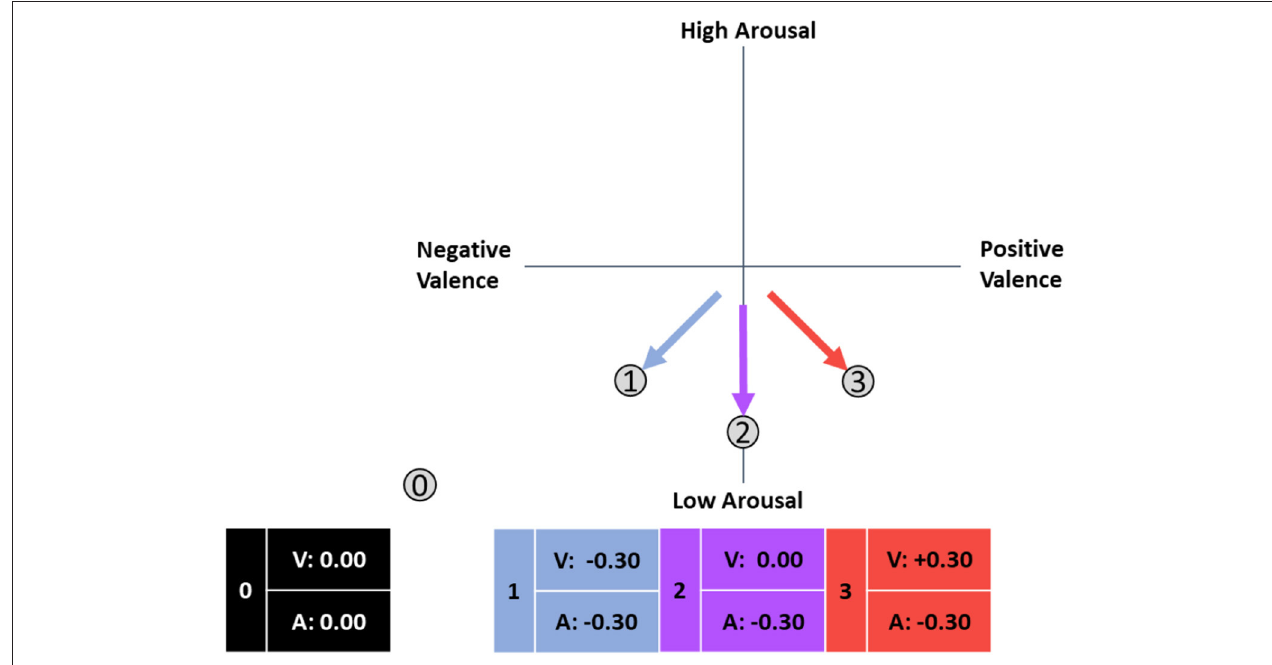
FIGURE 4 | Proposed framework of affective response categories in safety-critical systems in the circumplex model of affect (adapted from Russell,